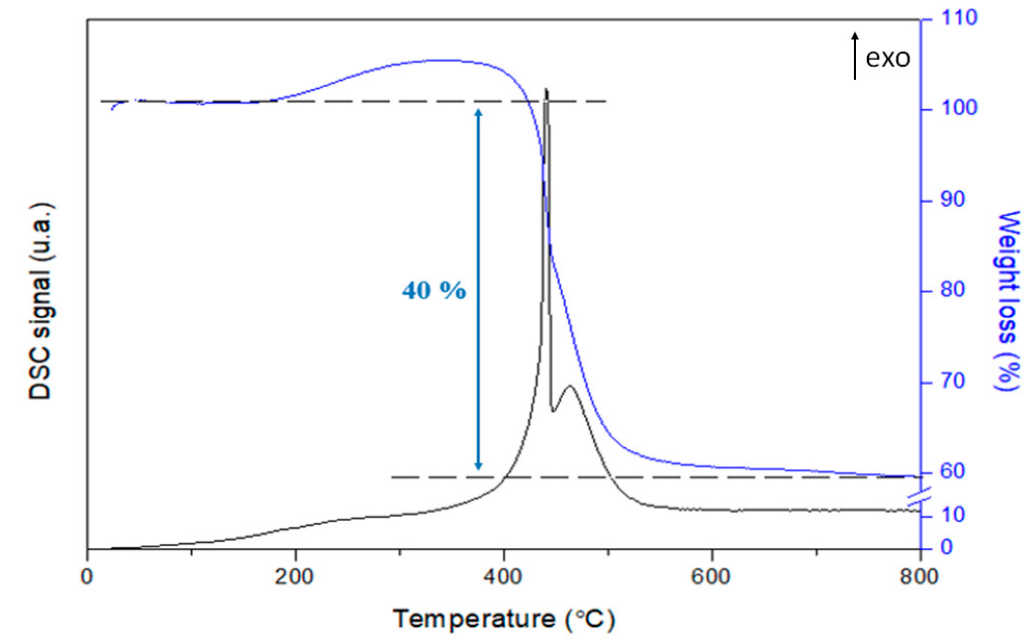
Figure 4. Thermal analysis under air of Co 2 Ni 2 Mg 2 Al 2 800 after stability test for 20 h at 800 °C.